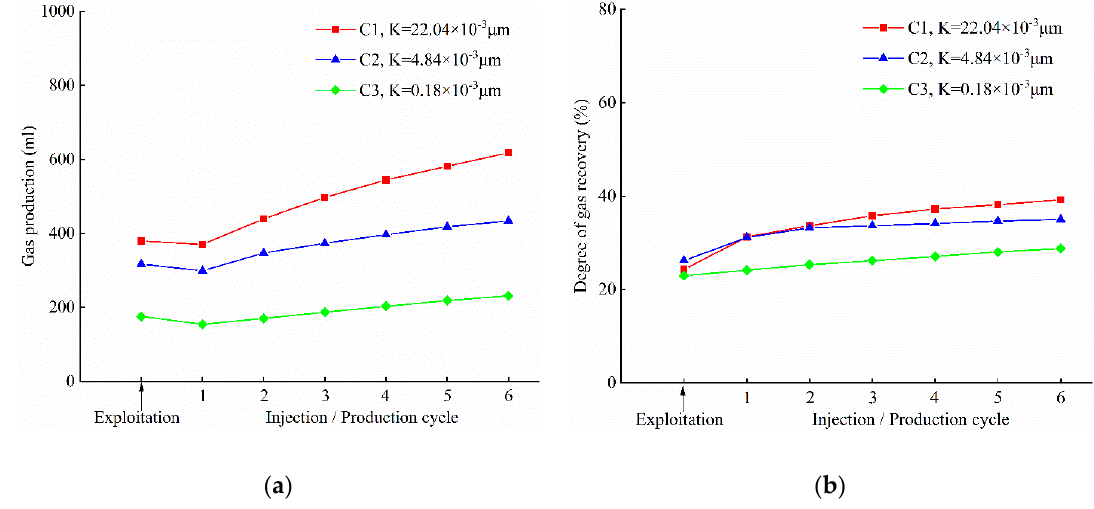
Figure 10. Variation curve of gas production ( a ) and degree of gas recovery ( b ) in the gas-drive-water gas zone.